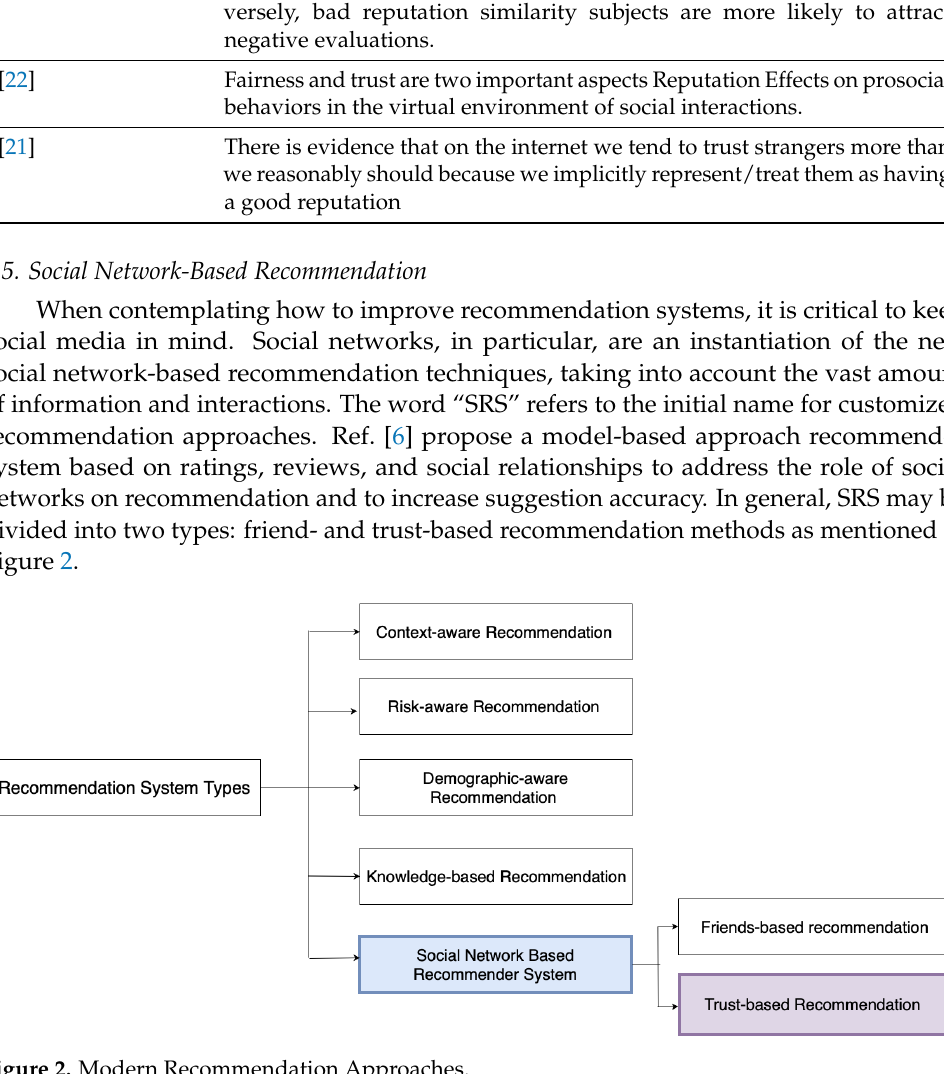
Figure 2. Modern Recommendation